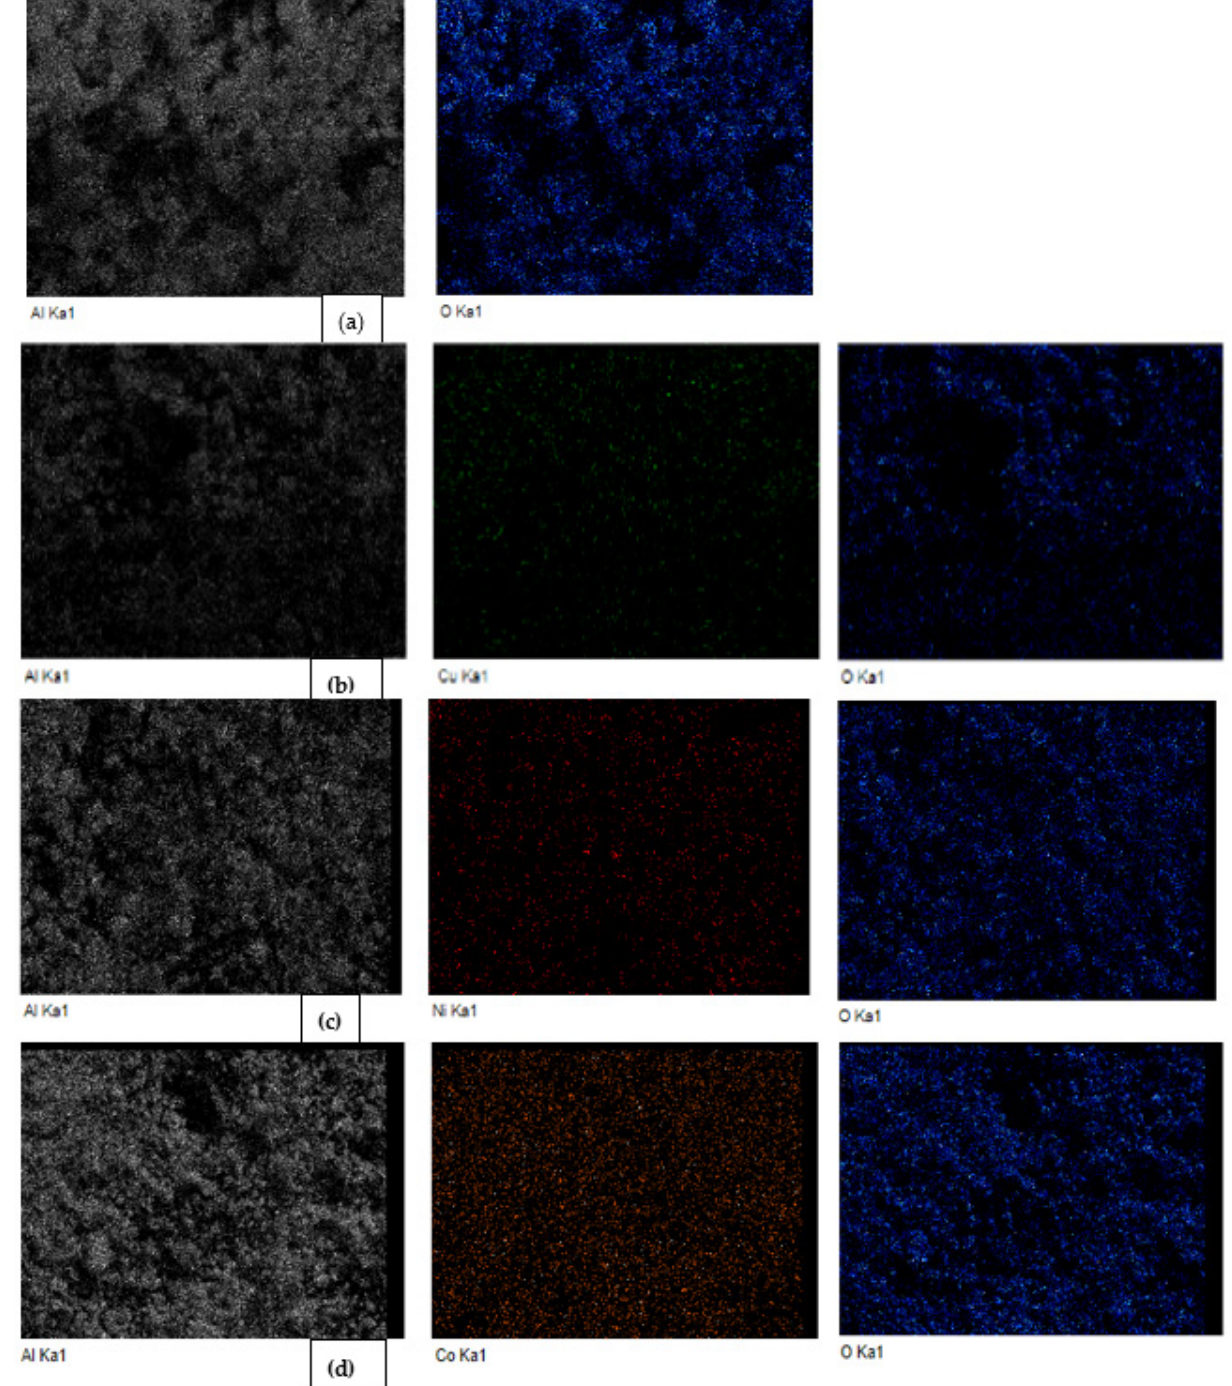
Figure 3. EDX mapping for the ( a ) Al2O3 nanoparticles, ( b ) Al 2 O 3 —CuO, ( c ) Al 2 O 3 —NiO, and ( d ) Al 2 O 3 —CoO nanocomposites.